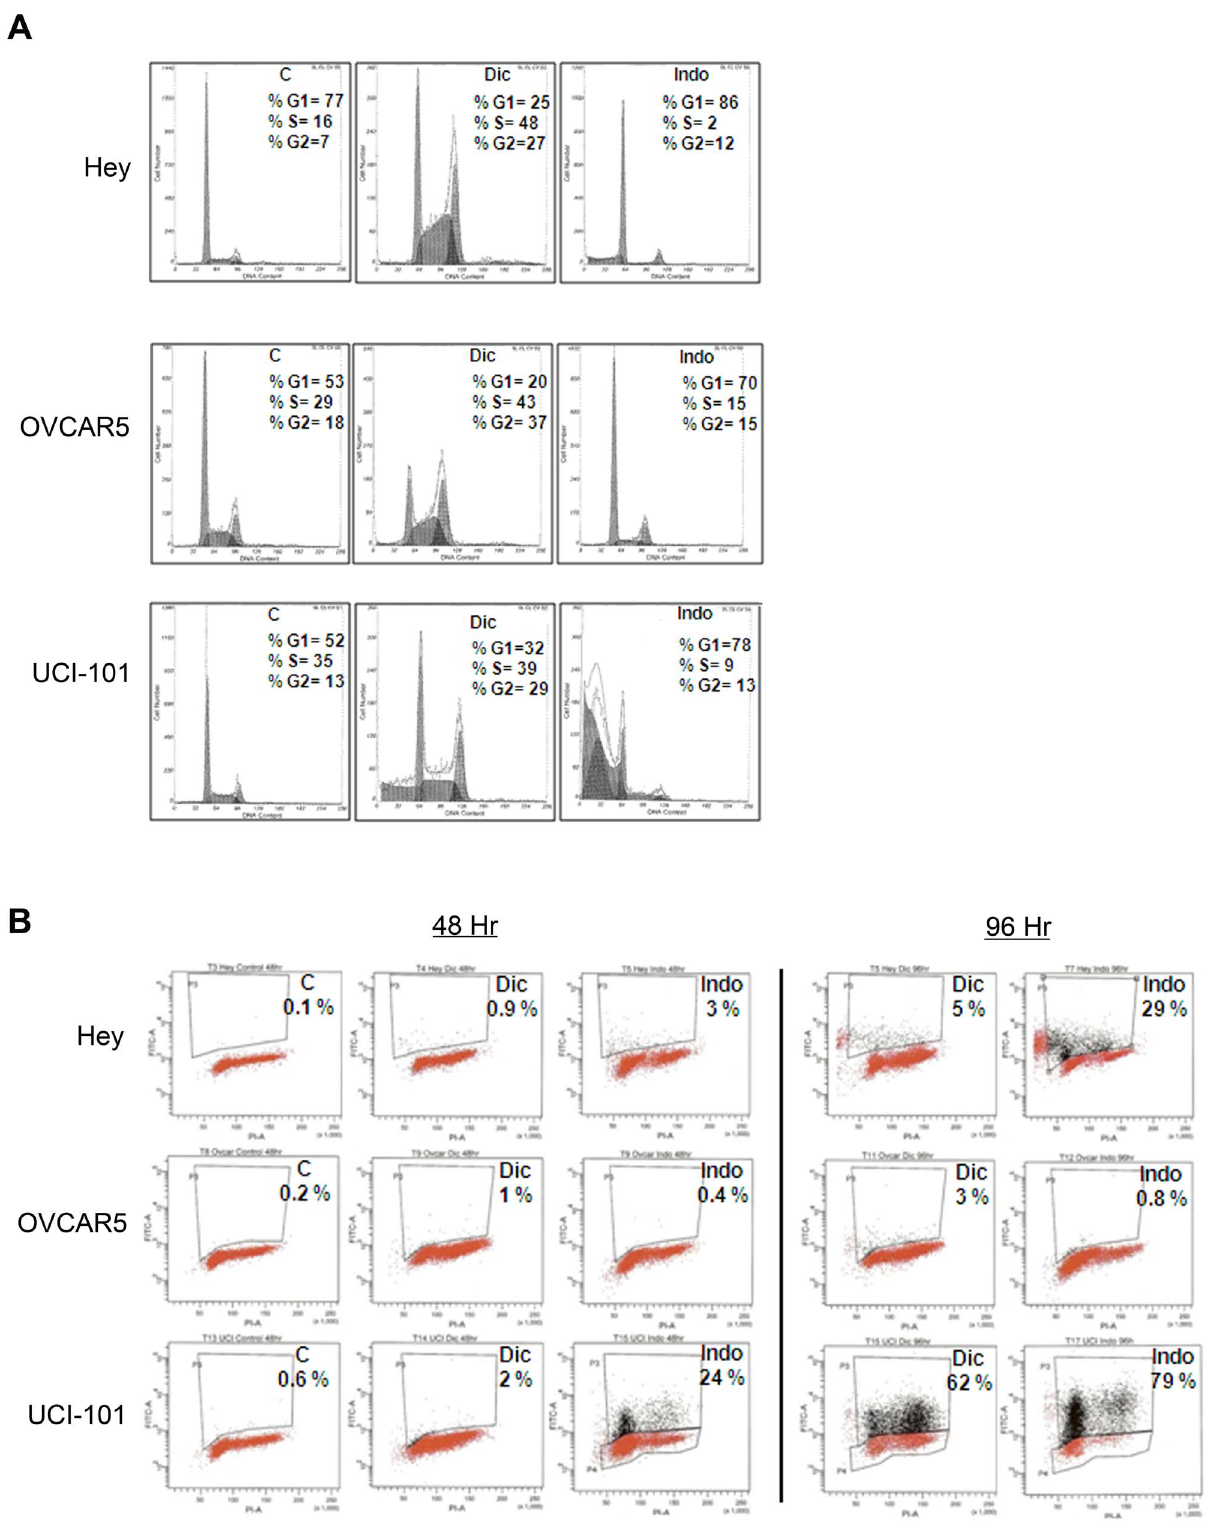
Figure 2. Diclofenac and Indomethacin promote cell cycle arrest and apoptosis in ovarian cancer cells. A) HEY, OVCAR5 and UCI-101 cells were treated for 24 hours with 300 m M diclofenac or indomethacin. Cells were labeled with propidium iodide and analyzed in a FACS Caliber Flow Cytometer. Image shown is representative of 4 experiments. B) Cells were treated for 48 or 96 hours with 300 m M diclofenac or indomethacin. Apoptosis and DNA content were assayed by BrdU and propidium iodide staining using Apo-BrdU kit. Cells in upper quadrant box (P3 gate) represent the apoptotic population.